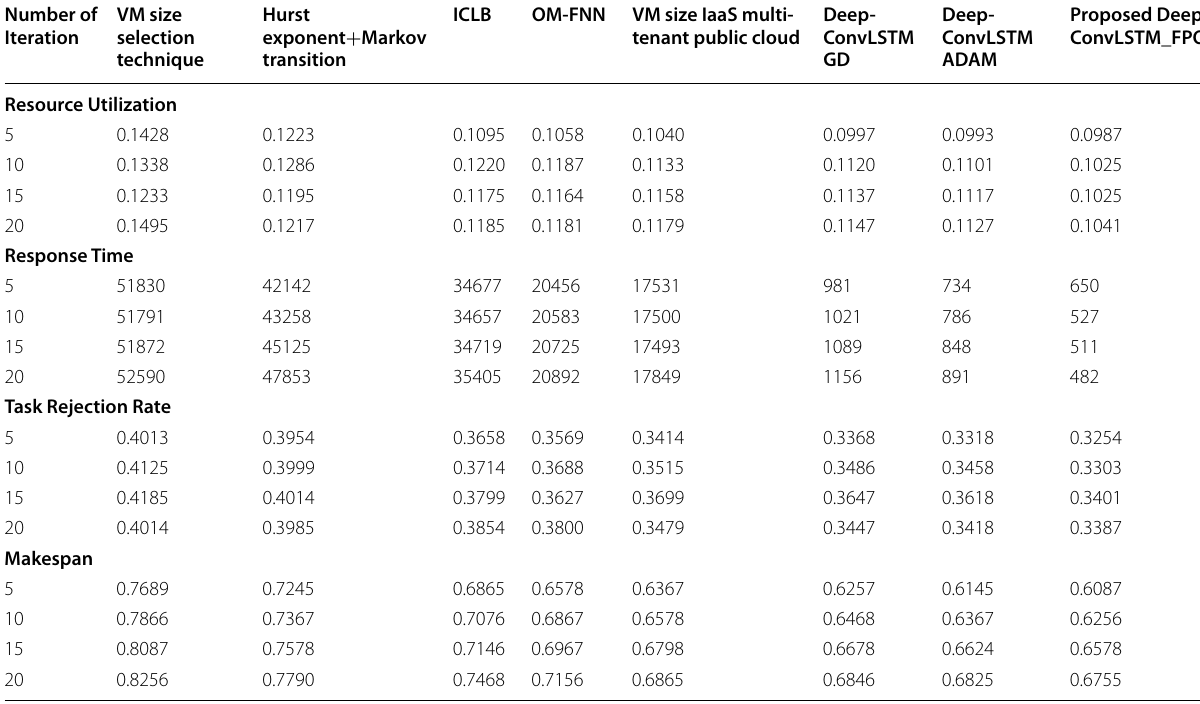
Table 8 Comparative Assessment of Deep-ConvLSTM_FPO Scheme With Task Size 300 Number of Iteration